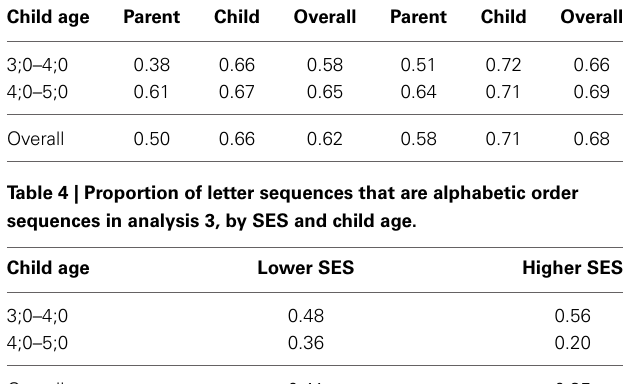
Table 4 . Lower SES families had a higher proportion of